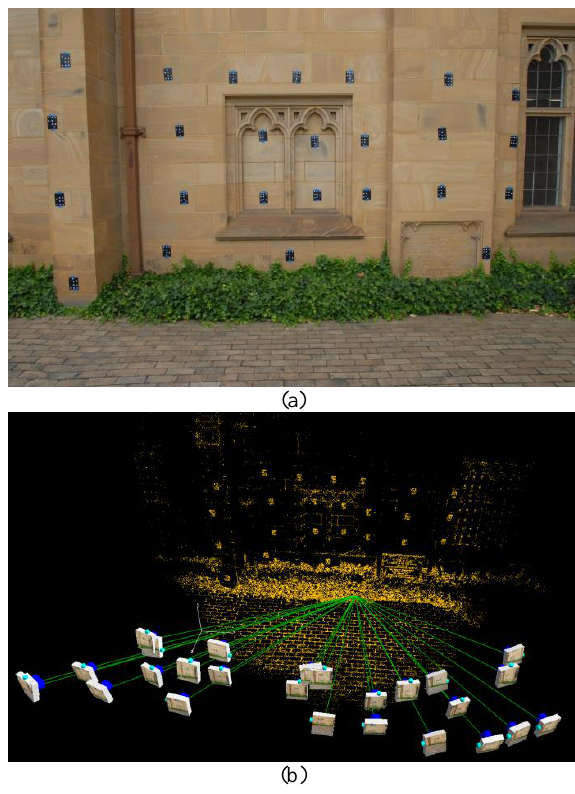
Figure 6. Configuration for 26,500-point ‘Brick Wall’ self- calibration